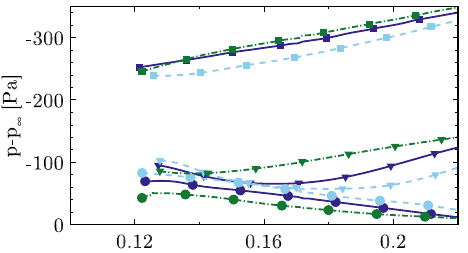
Figure 26. The effect of the blade position on radial pressure distribution on the suction side at x c /c ≈ 0 . 1 (squares), x c /c ≈ 0 . 5 (triangles) and x c /c ≈ 0 . 85 (circles) for CaseT1.4 (solid),